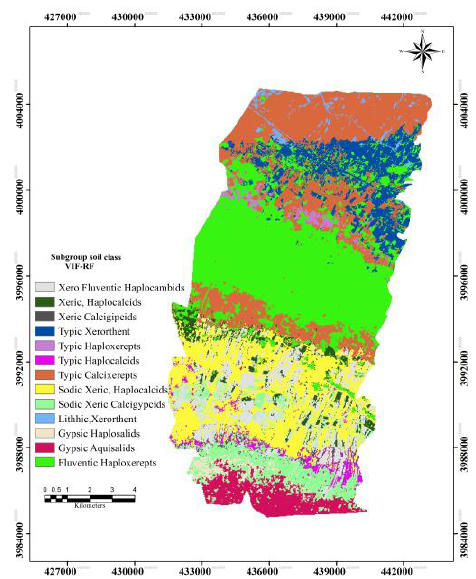
Figure 3. Spatial distribution of the soil subgroups derived from RF